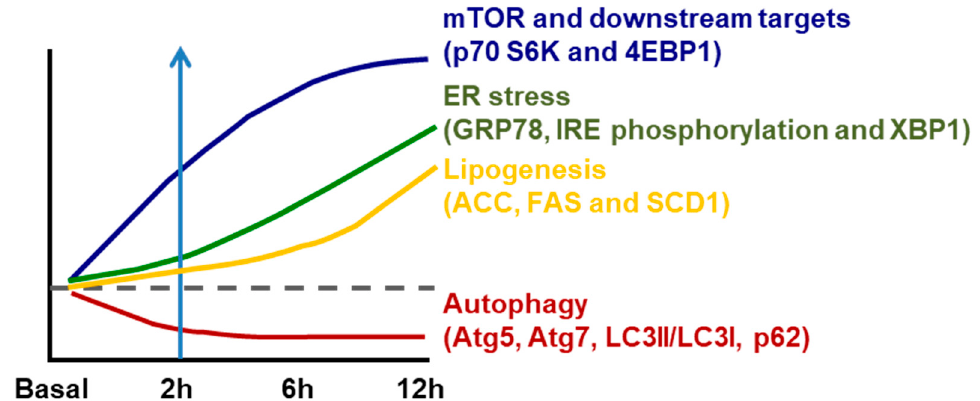
Figure 1. Temporal changes in ER stress associated lipogenesis following mammalian target of rapamycin (mTOR)-coupled autophagy inhibition induced by dietary fructose. However, the activation of mTOR and its downstream p70 S6K and 4EBP1 is parallel with inhibition of autophagy (Atg5, Atg7, LC3II/LC3I and p62) within 2 h of high-fructose feeding. This is followed by increased ER stress (inositol-requiring enzyme 1/X-box binding protein, IRE1/XBP1) (starting from 6 h) and subsequent increase in lipogenesis (acetyl CoA carboxylase (ACC), fatty acid synthase (FAS) and stearoyl-CoA desaturase-1 (SCD1)) (after 6 h). Diagram redrawn based on [7].